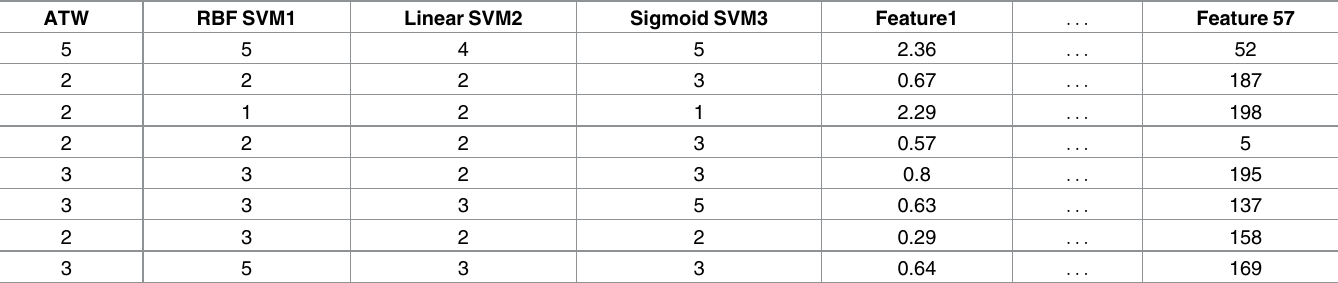
Table 4. The results after the SVMs in three different kernel